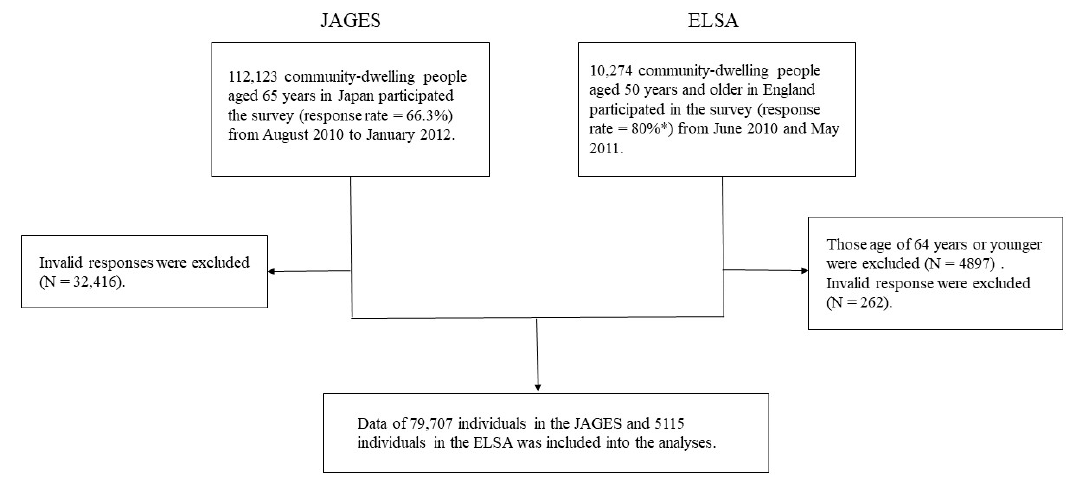
Figure 1. Flowchart of the selection of participants for the study (JAGES, Japan Gerontological Evaluation Study; ELSA, English Longitudinal Study of Ageing). * This response rate was taken from cohort profile of ELSA [23].